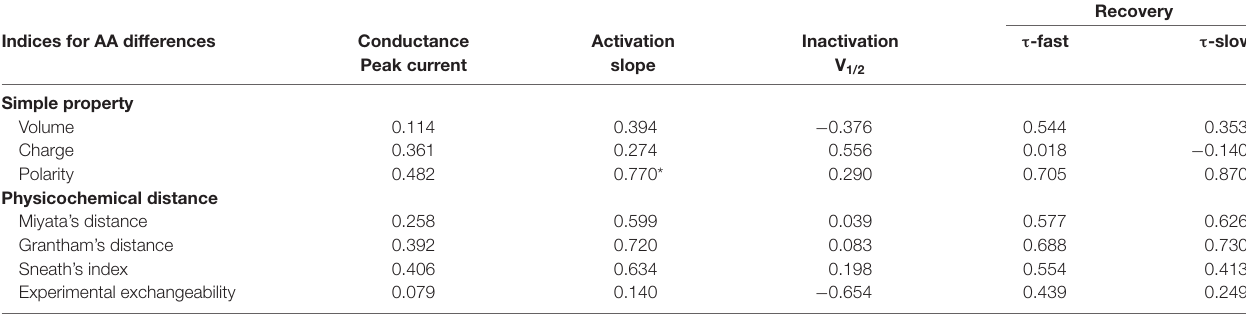
TABLE 1 | Correlation coefficients between residue similarity and functional